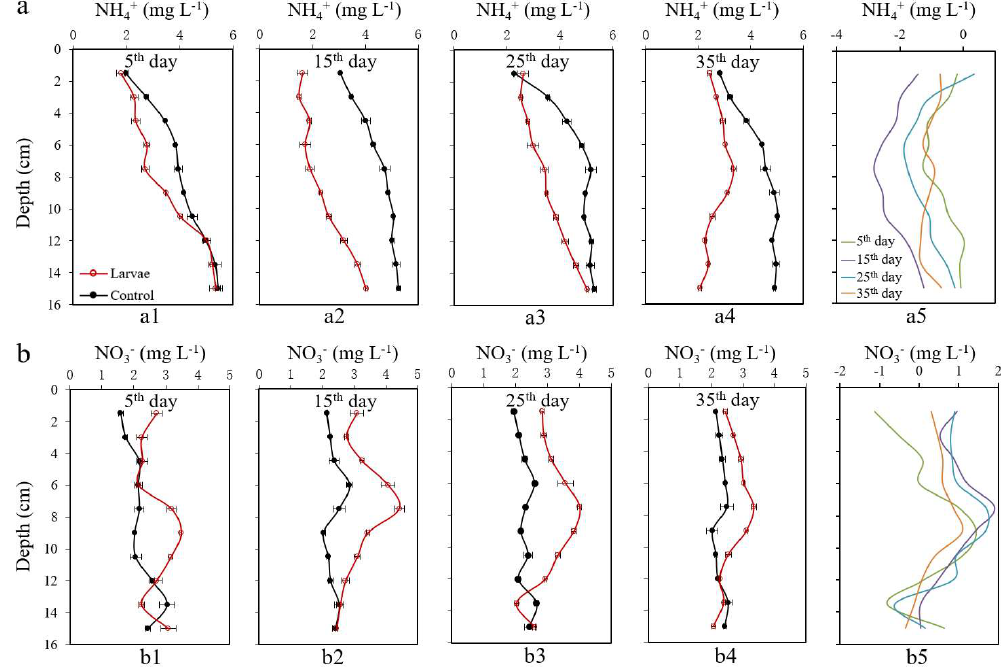
Figure 5. Ammonium nitrogen (NH 4+ ) and nitrate nitrogen (NO 3− ) profiles in pore water collected by Peeper of the control and the Chironomid larvae treatment. ( a ) NH 4+ and ( b ) NO 3− . ( a5 ) NH 4+ and ( b5 ) NO 3− in pore water changes in treatment minus changes in control on the 5th, 15th, 25th and 35th day, respectively.